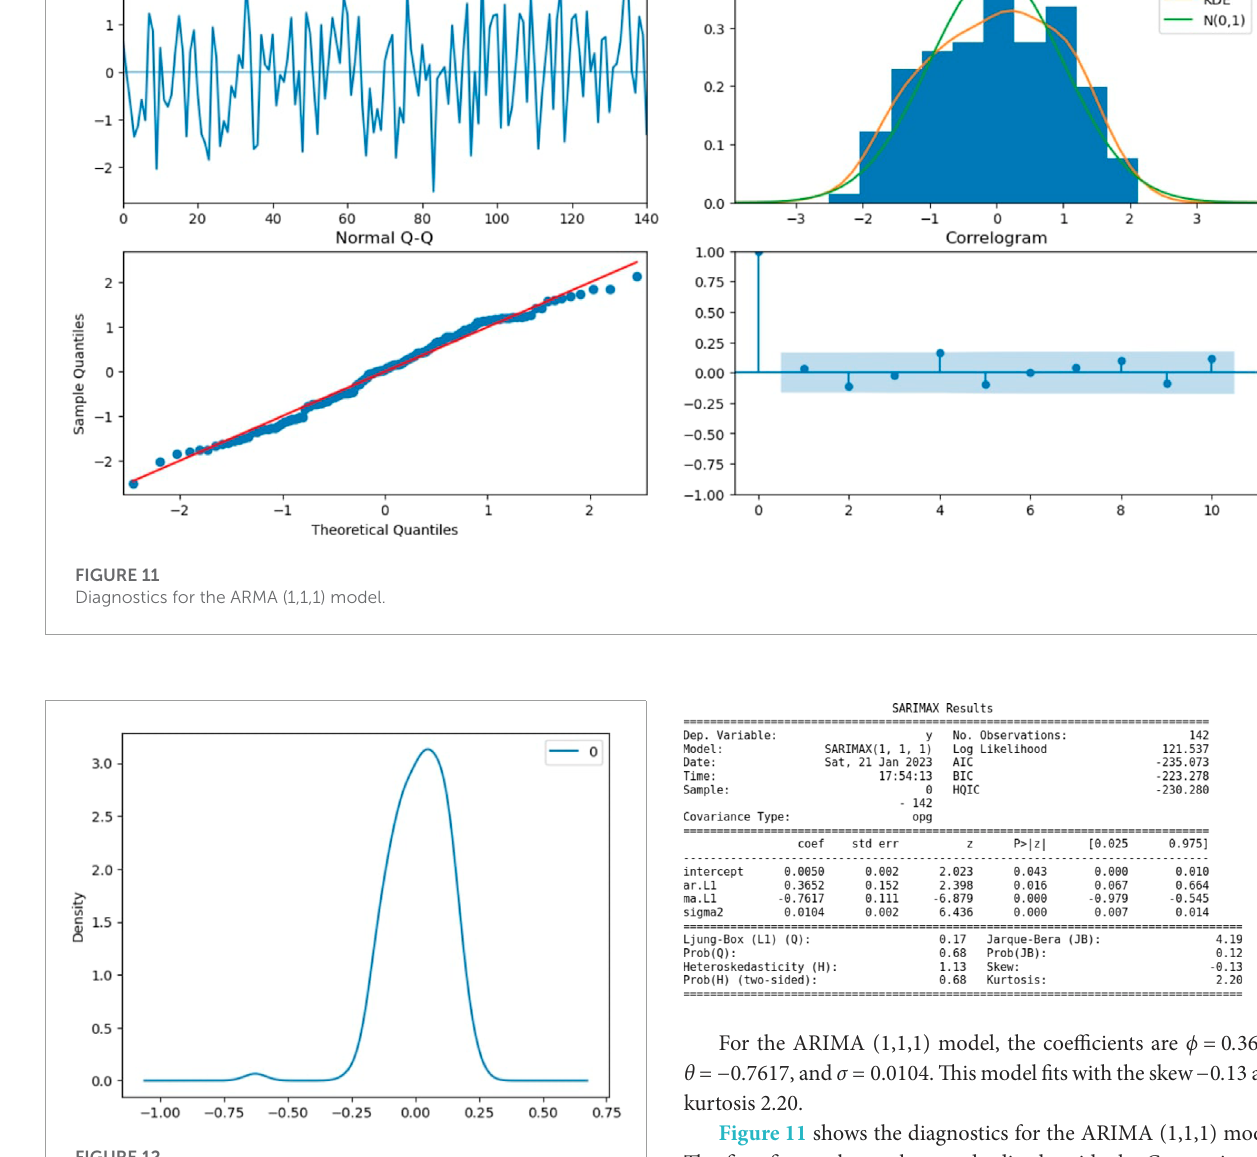
FIGURE 12 Density of residuals for ARIMA